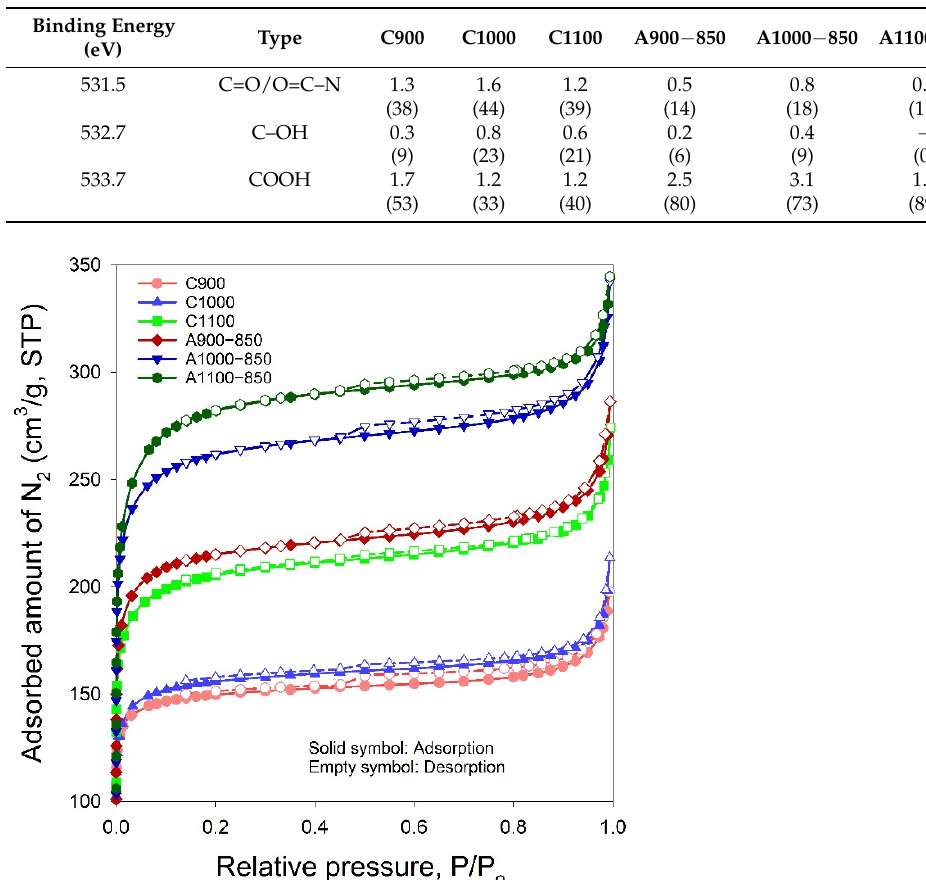
Figure 5. X-ray photoelectron spectroscopy (XPS) O 1 s spectra: ( a ) C900; ( b ) C1000; ( c ) C1100; ( d ) A900 − 850; ( e ) A1000 − 850; and ( f ) A1100–850. The values are given in an atomic ratio (%) of total intensity. Table 4. Results of the fits of the XPS O 1 s region, values given in at% (percent of total intensity).